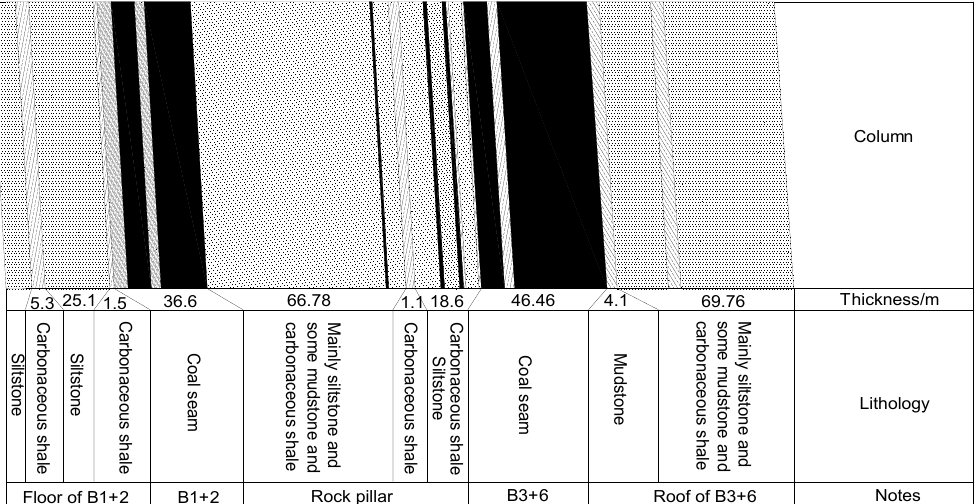
Figure 3. Distribution of the coal seams and rock (modified according to He et al. [39]. (Reproduced from [39], Elsevier: 2019.).